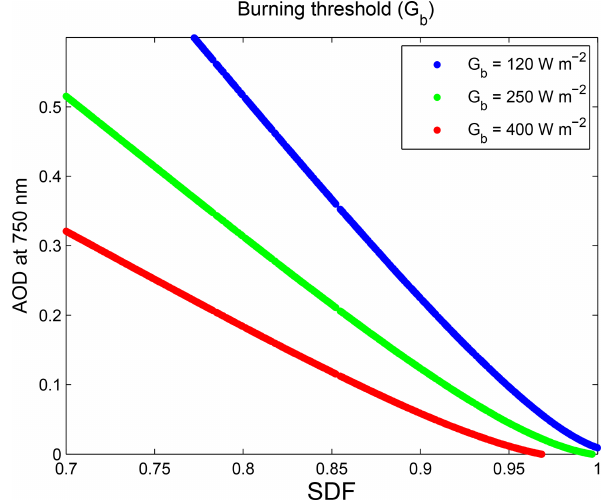
Figure 2. AOD at 750nm as a function of SDF for three burning